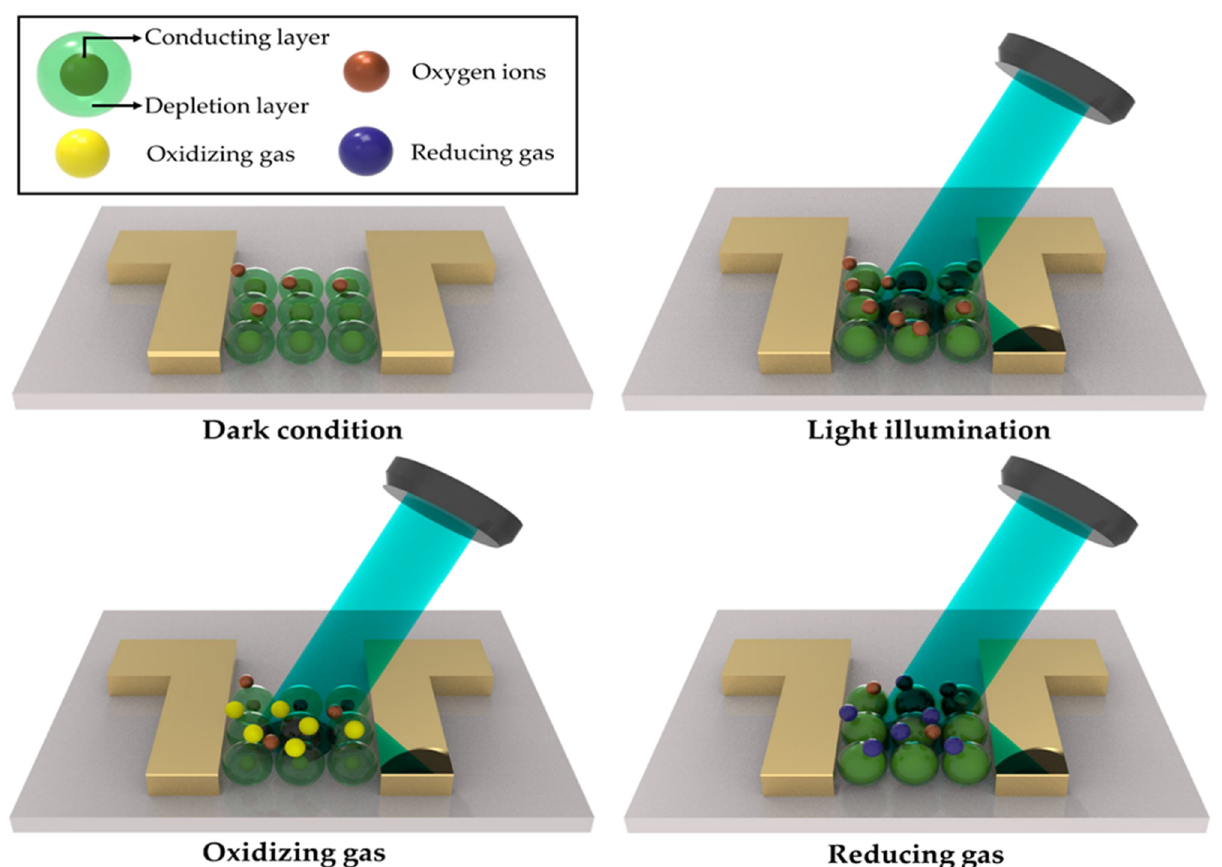
Figure 1. Surface statement of n − type metal oxide semiconductor − based photo − activated gas sensor under oxidizing gas and reducing gas.